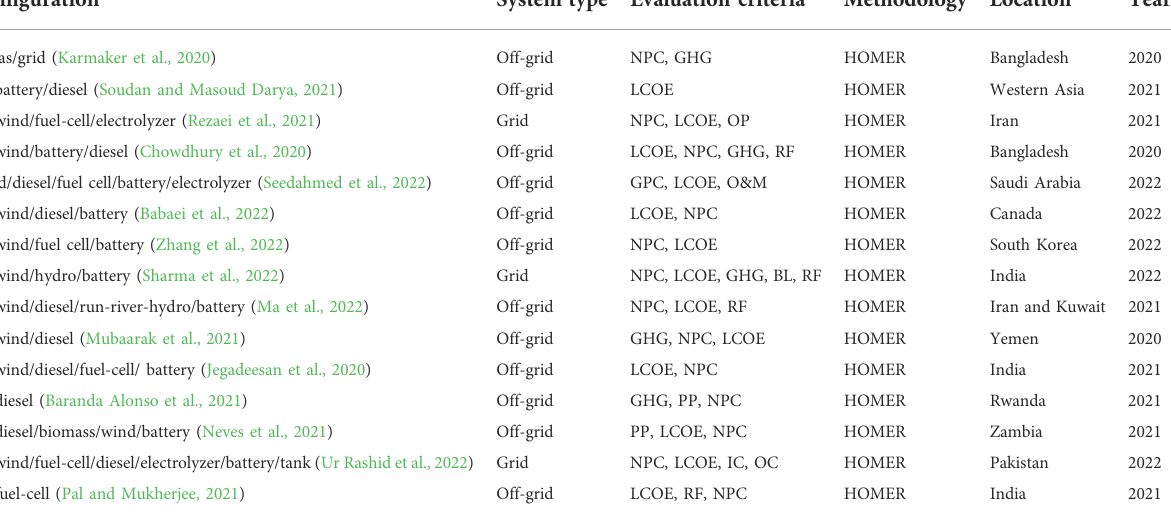
TABLE 1 Summary of some recent studies on different